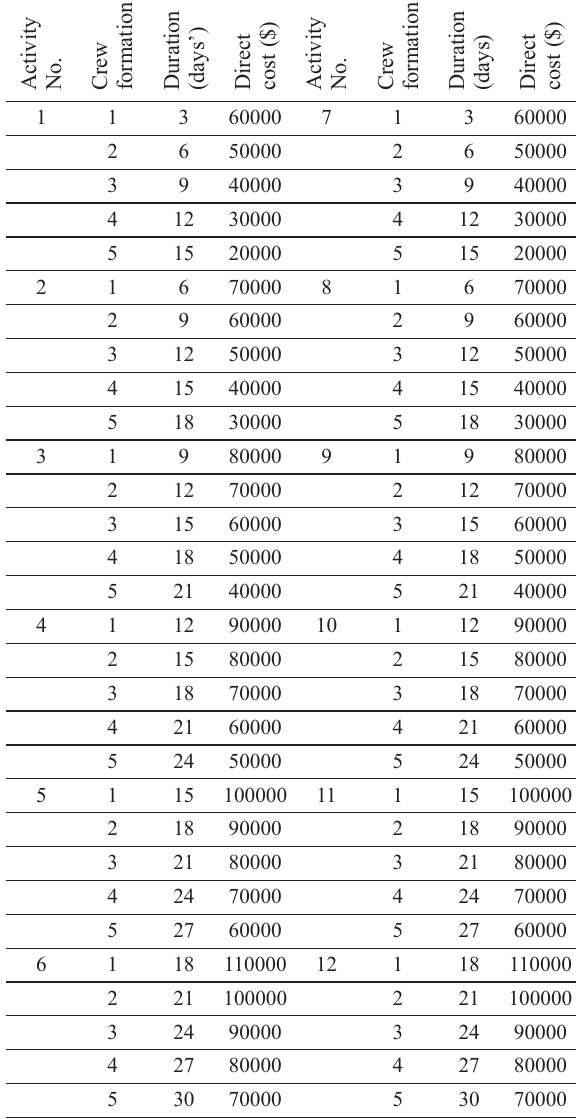
Table 2. Activity durations and direct costs